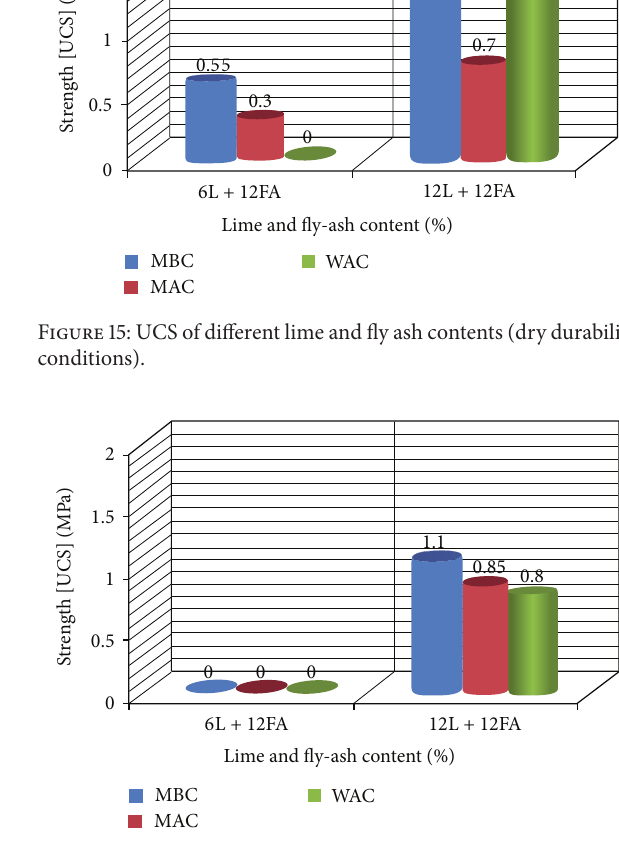
Figure 16: UCS of different lime and fly-ash contents (soaked durability